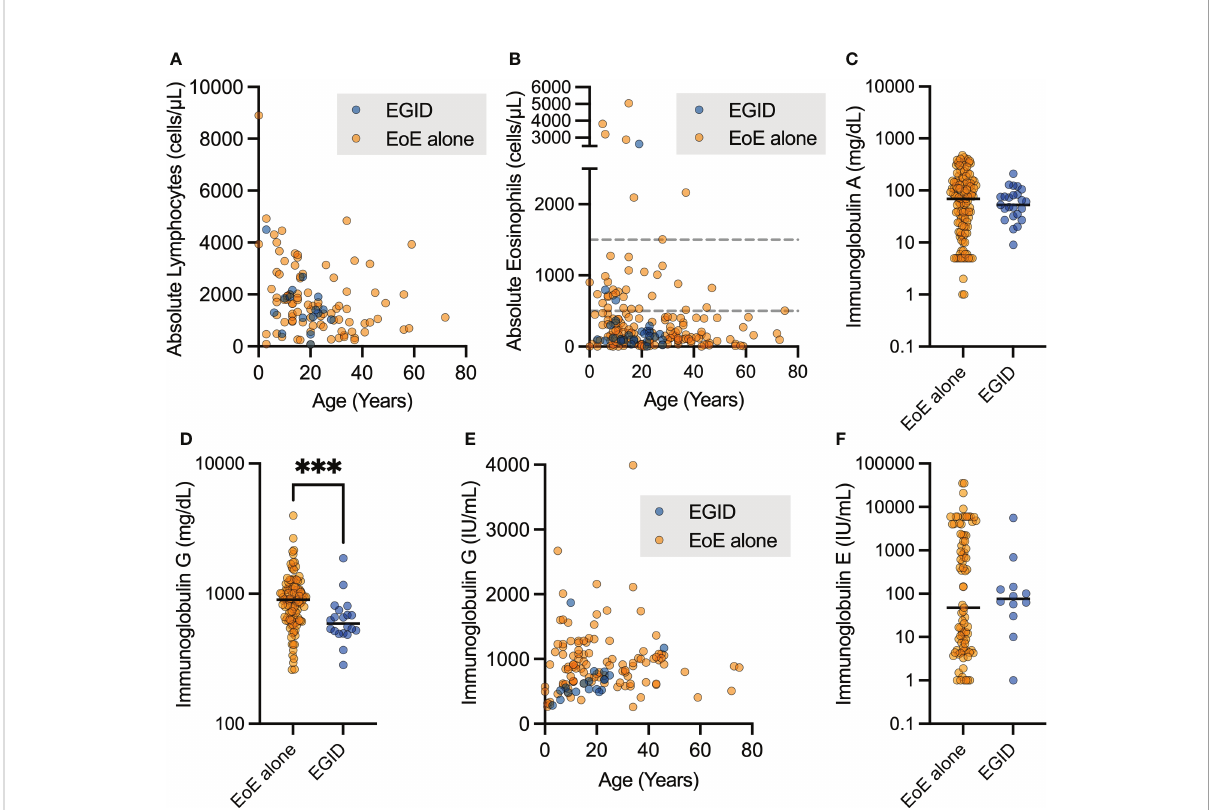
FIGURE 3 Patients with non-EoE EGID have lower uncorrected immunoglobulin G levels. The aggregate lab values for patients with EoE and non-EoE EGID are shown for the (A) absolute lymphocyte count and (B) absolute eosinophil count from CBC with differential measured in cells per microliter (dashed lines indicate 500 and 1500 cells per m L). (C, D) Serum immunoglobulin G levels in mg/dL were signi fi cantly lower in patients with EGID compared to those with EGID alone (***p=0.0008, Mann-Whitney U test) and (E) showed expected age-related increase over childhood years. Patients on immunoglobulin in replacement therapy were excluded from this analysis. (F) Serum immunoglobulin E levels were not signi fi cantly different between patients with EGID and EoE, and a subset of patients had signi fi cantly elevated